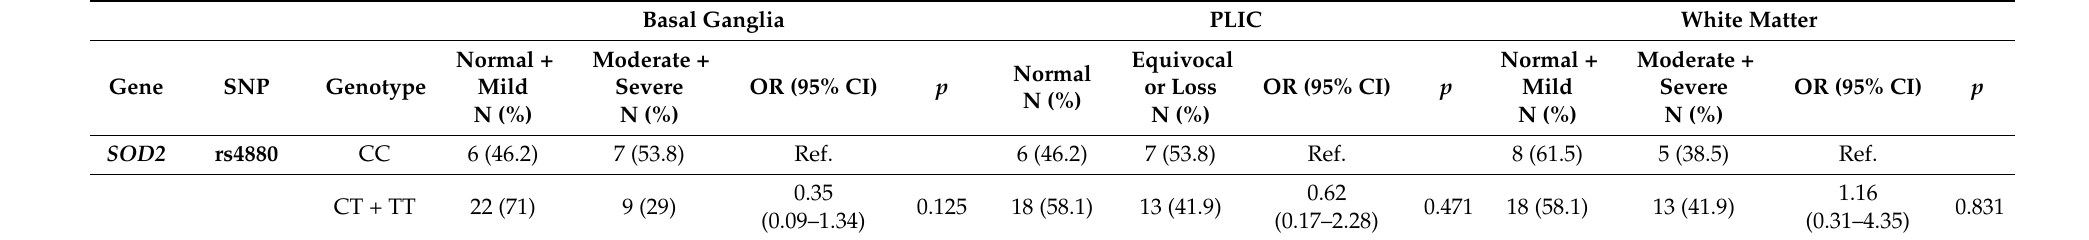
Table 4. The association of polymorphisms with MRI brain